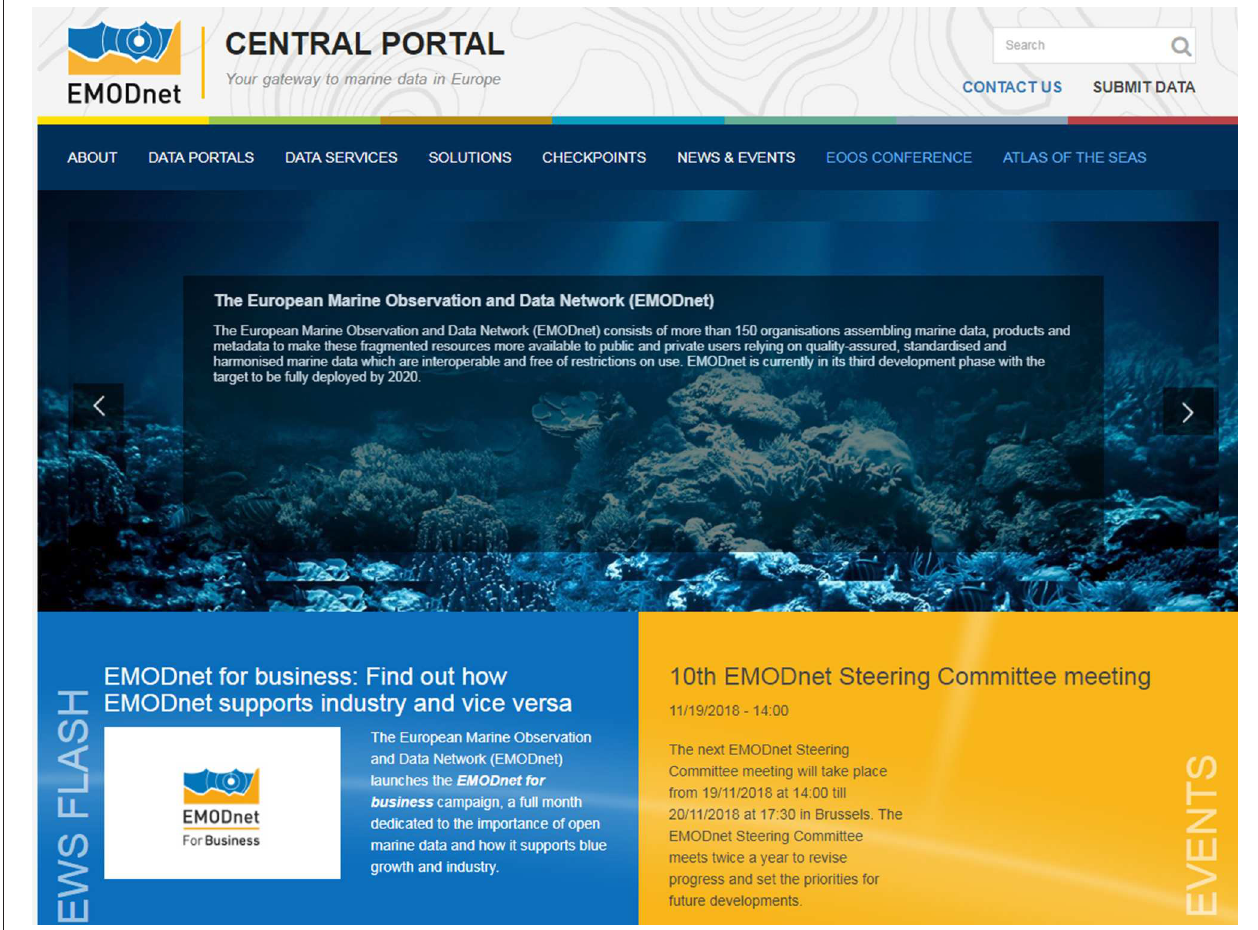
FIGURE 7 | Entry page of EMODnet Central Portal website providing a unified access to all EMODnet